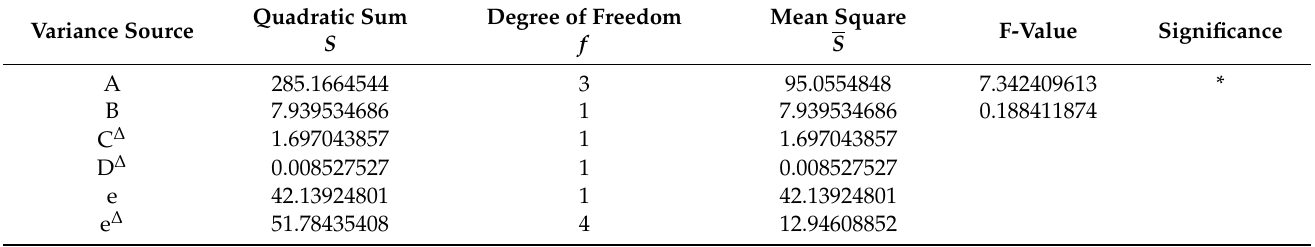
Table 6. Analysis of variance (ANOVA) of joint simulation results under 10 MHz electromagnetic wave incidence.